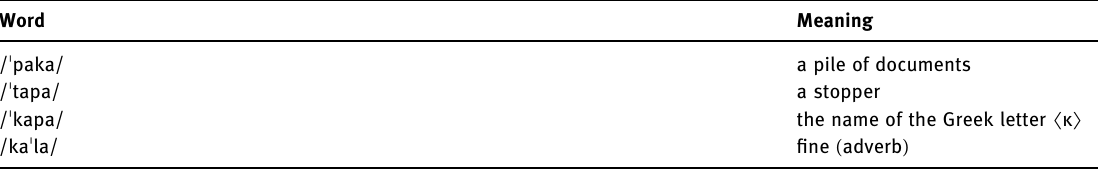
Table A3: Meaning of real words in